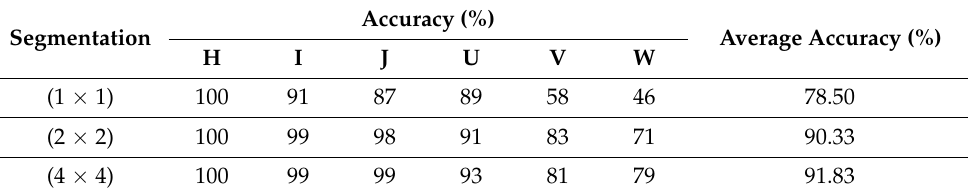
Table 8. Comparison of the results obtained using different divided blocks with occlusion by